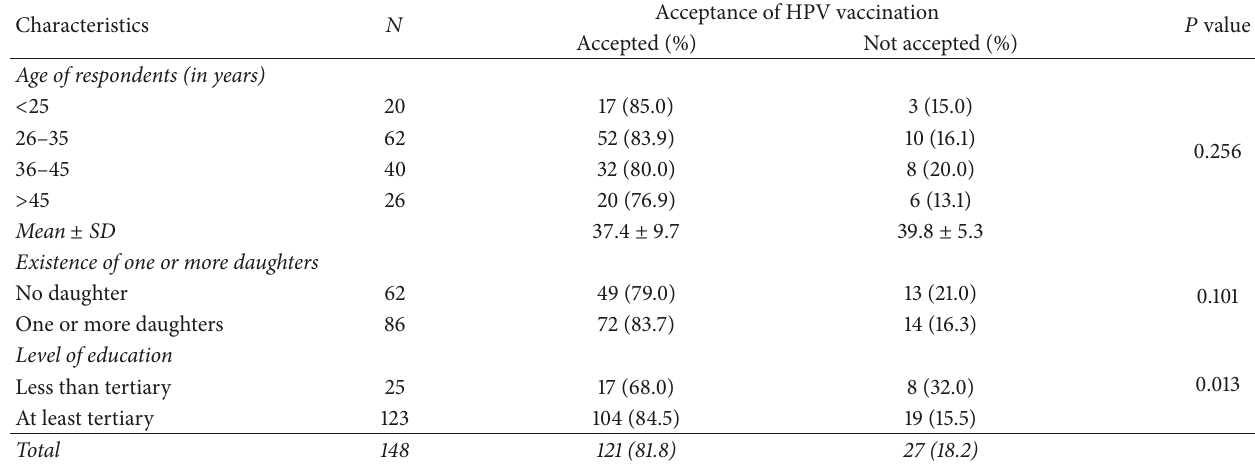
Table 5: Association between sociodemographic characteristics of respondents and their acceptance of HPV vaccination for their adolescent girls ( 𝑁 = 148